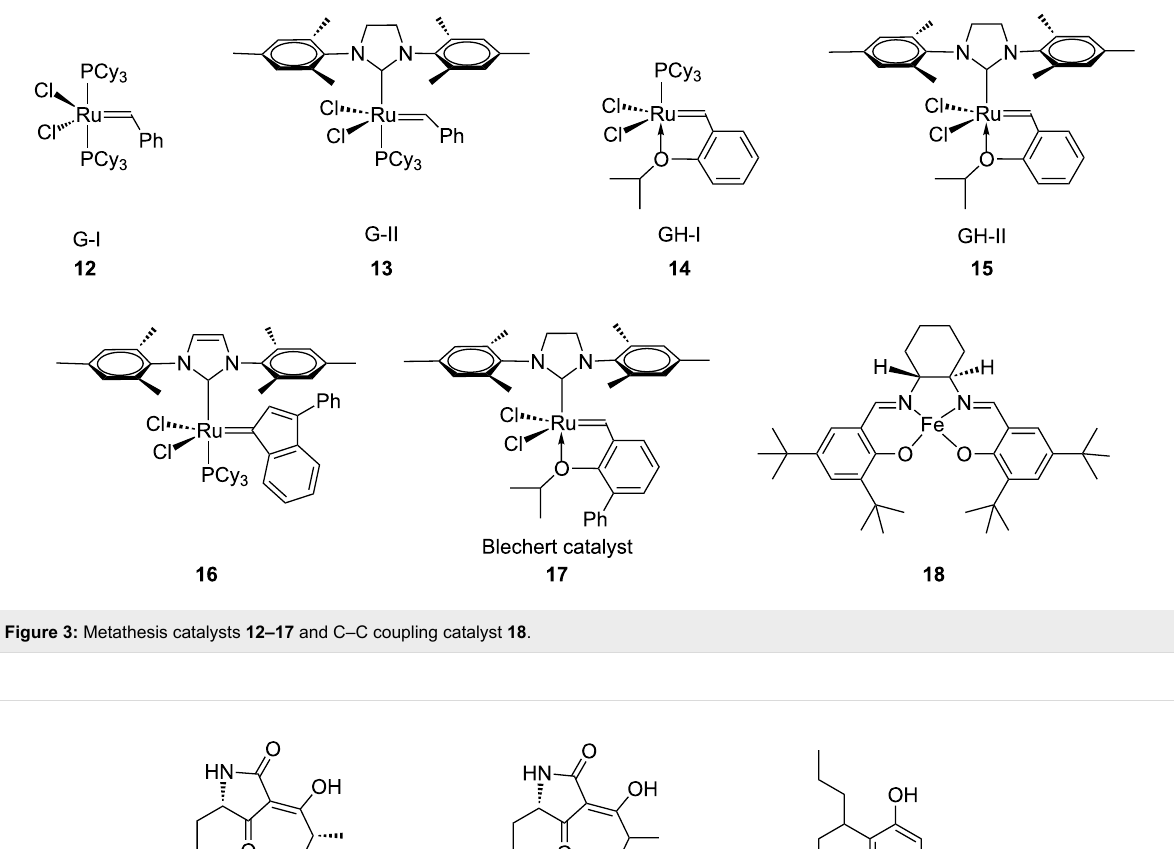
Figure 3: Metathesis catalysts 12–17 and C–C coupling catalyst 18 .